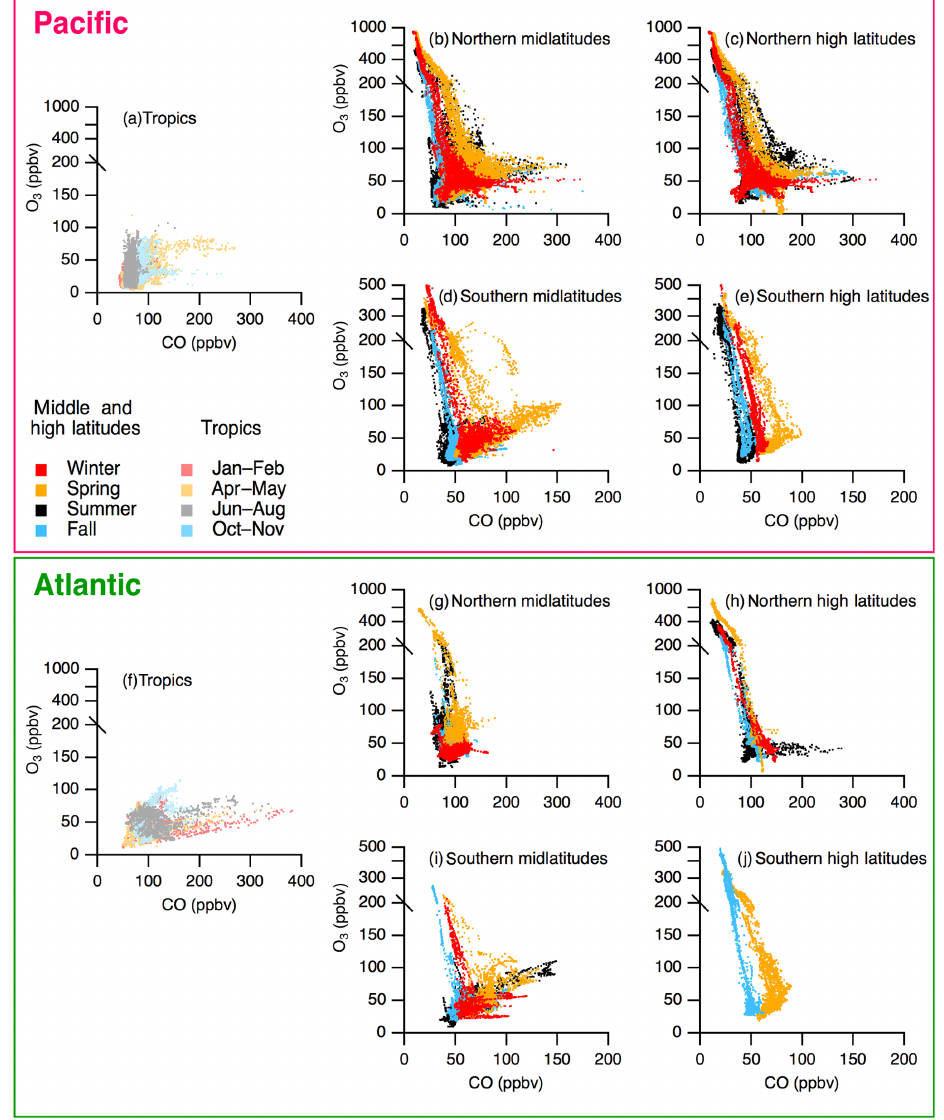
Figure 13. O 3 vs. CO plots using combined ATom and HIPPO data. Each panel denotes a different latitudinal band in each basin. Seasonal deployments are colored according to the legend. Note the logarithmic scale on the y axes in all panels and the changing scale with latitudinal